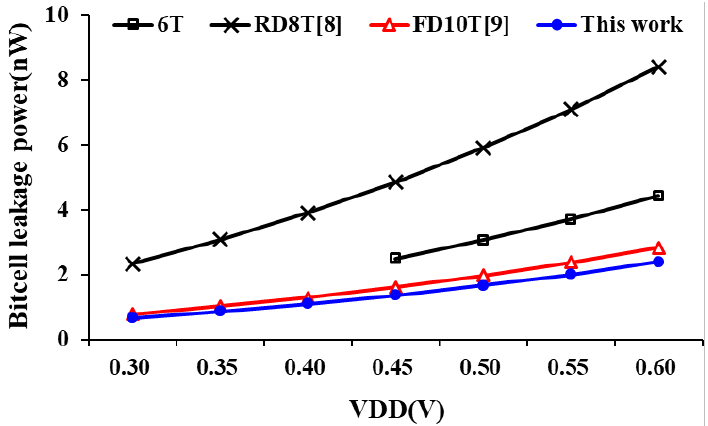
Figure 15. Comparison of bit-cell leakage power consumption.